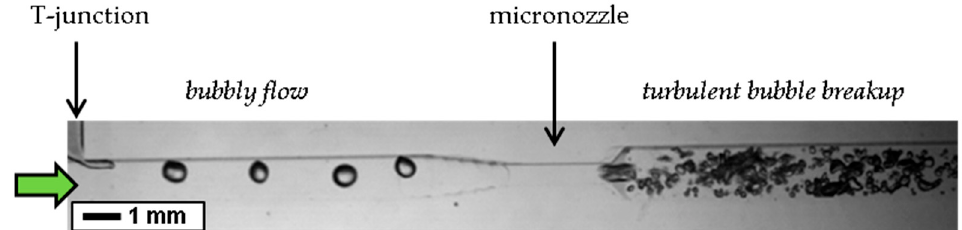
Figure 3. Bubble generation in T-junction (left) and turbulent dispersion downstream of the nozzle with Re 0 = 3732 and Re 1 = 1846.